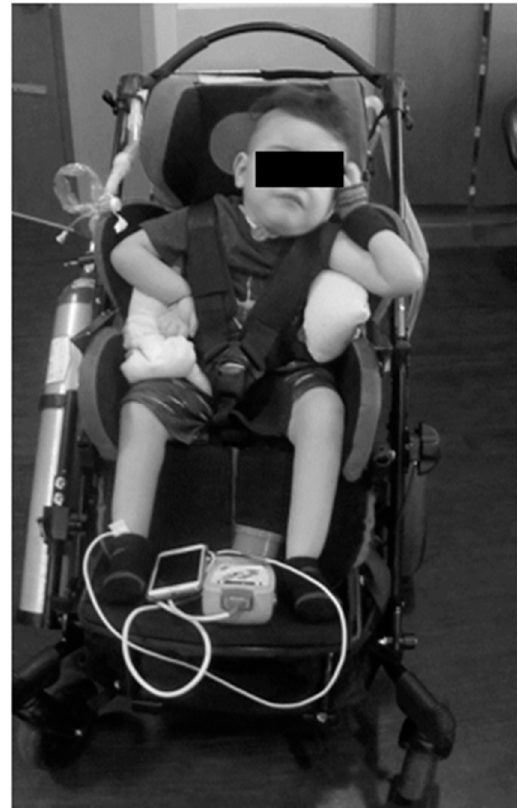
Figure 1. Patient’s initial presentation to clinical program. The patient relies on lateral supports of stroller and additional padding to assist with upright maintenance of trunk; however, he still demonstrates left lateral trunk lean and resting head on head support. He demonstrates preferential posturing with bilateral upper extremities.